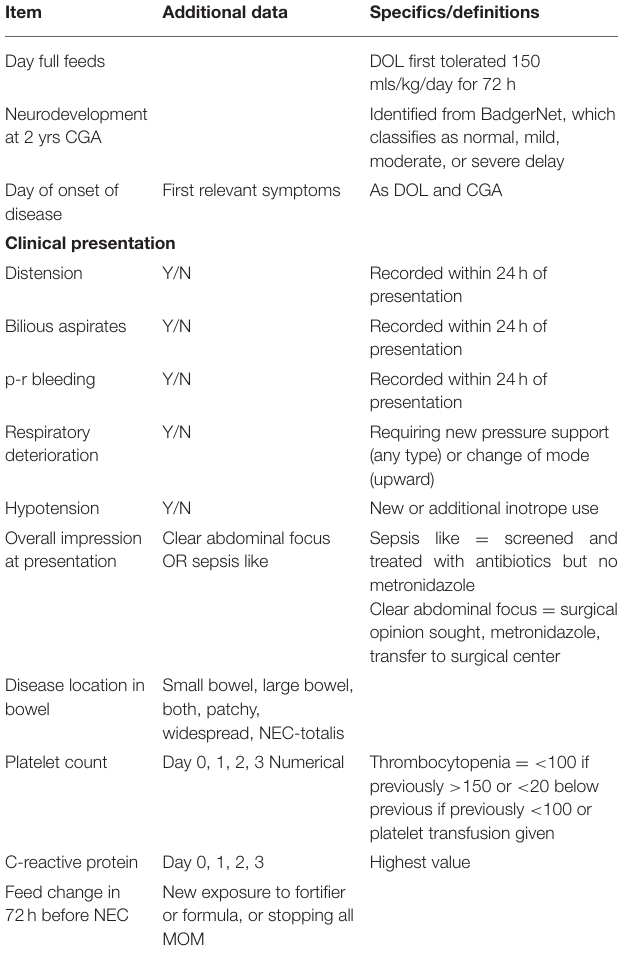
TABLE 1 | Key data